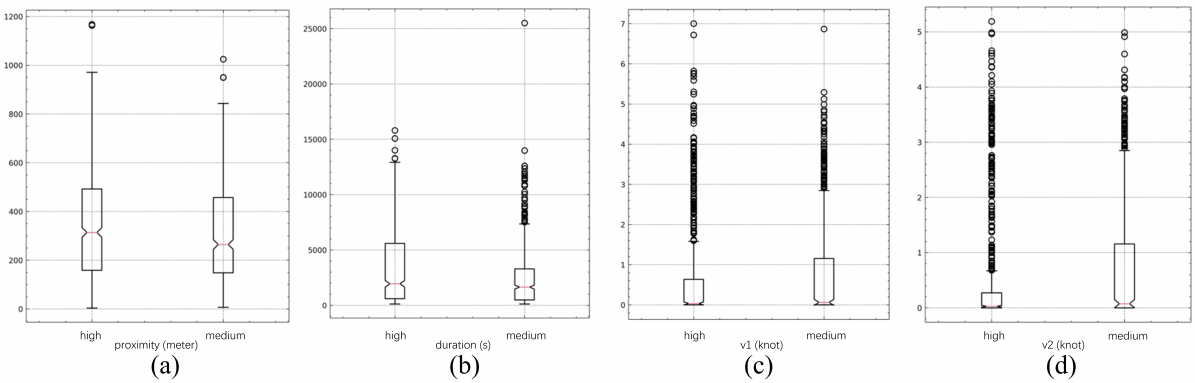
Figure 8. The high and medium-suspicious event features: ( a ) average proximity; ( b ) duration; ( c ) average speed of vessel 1; ( d ) average speed of vessel